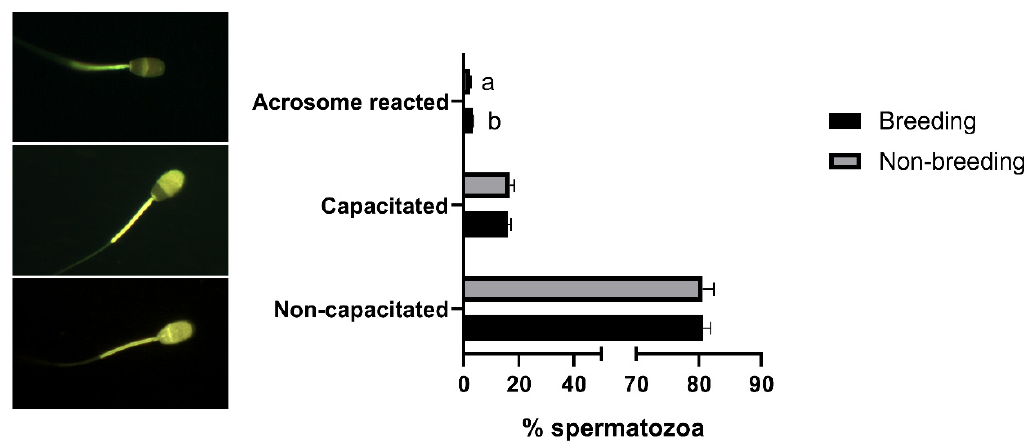
Figure 2. Seasonal differences in sperm capacitation state in Rasa Aragonesa rams. Results are shown as mean ± SEM of n = 56 (breeding season) and n = 40 (non-breeding season). Different letters indicate p < 0.05. Representative images of a non-capacitated, capacitated and acrosome-reacted spermatozoa are also shown.